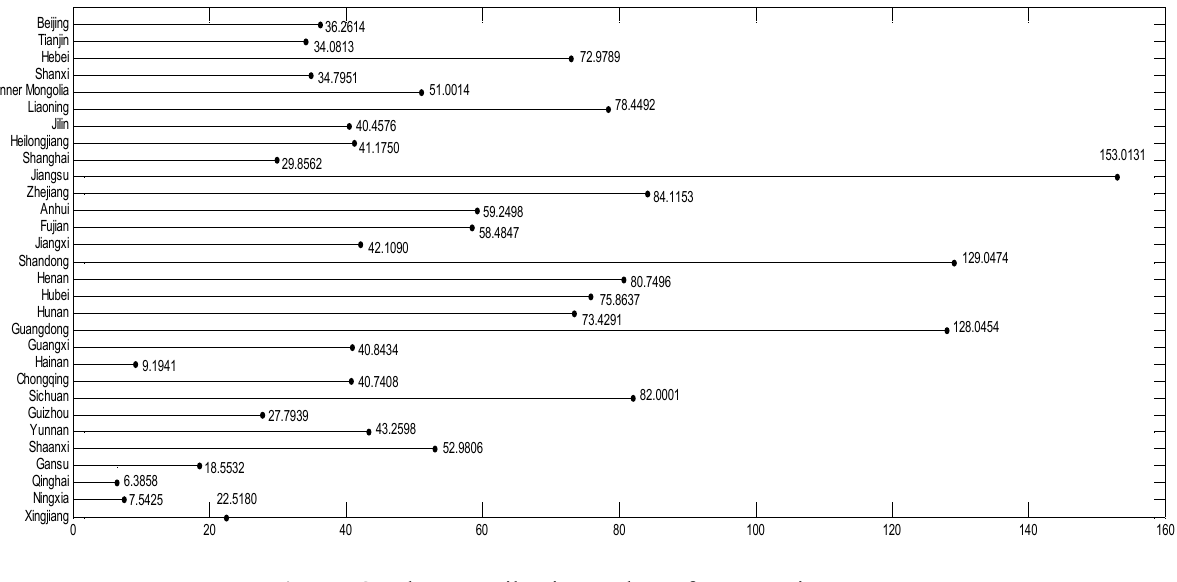
Figure 8. The contribution value of economic